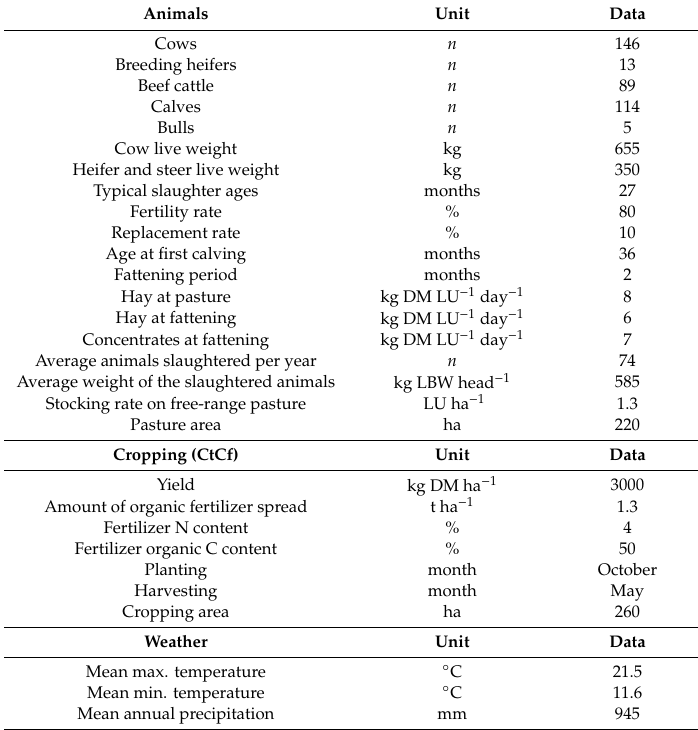
Table 1. Main herd, weather, and crop management